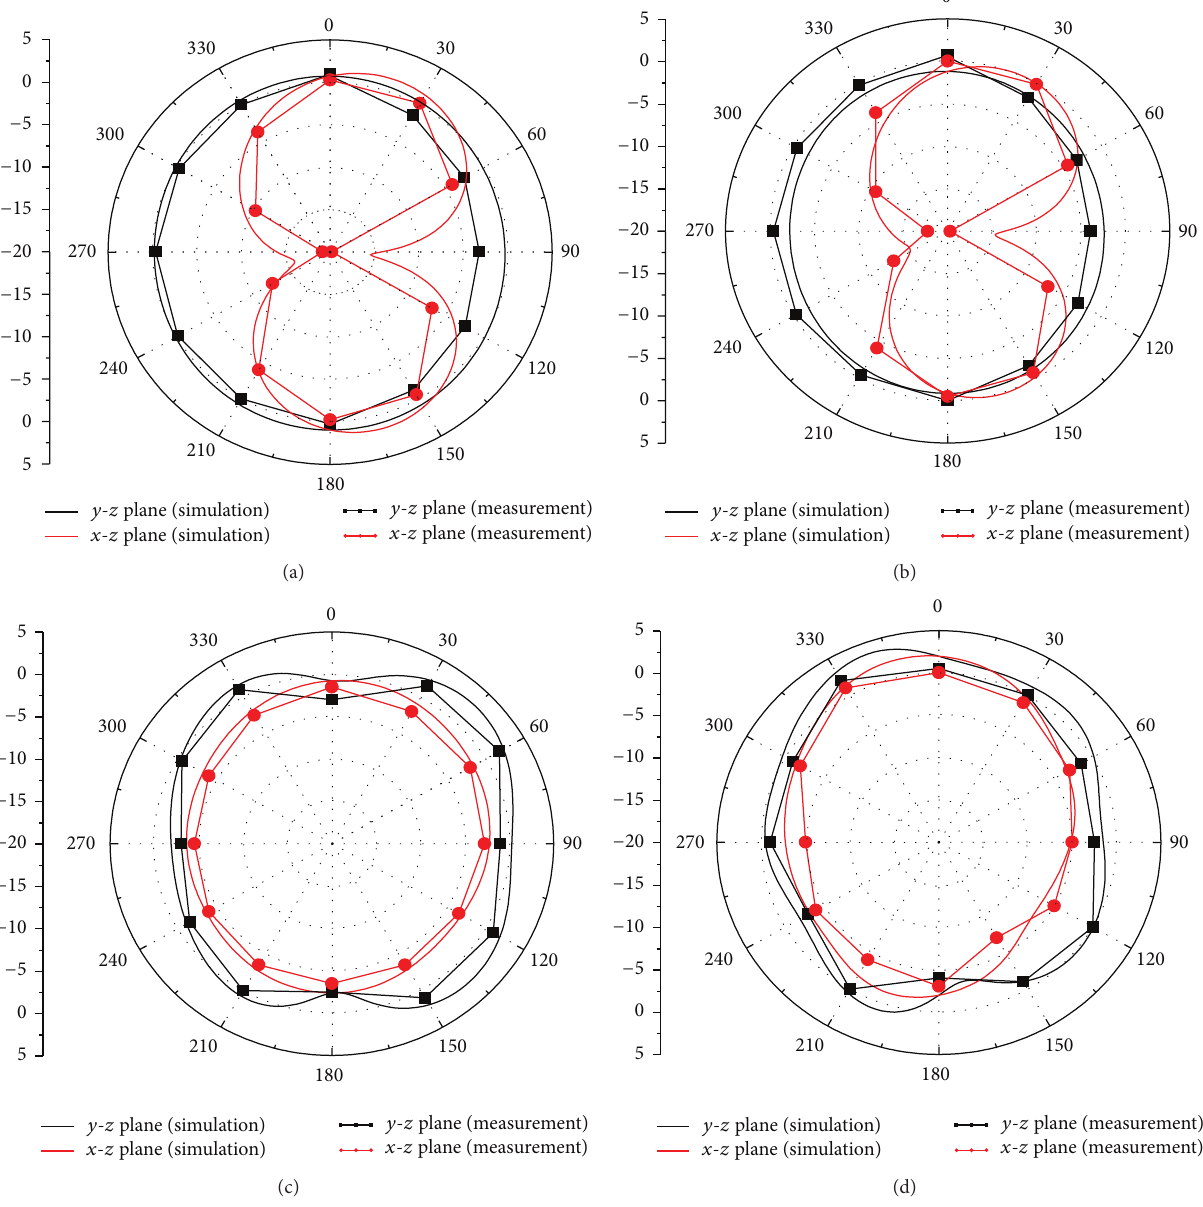
Figure 9: Simulated and measured far-field radiation patterns at resonant frequencies (a) 870 MHz, (b) 950 MHz, (c) 1750 MHz, and (d) 2100